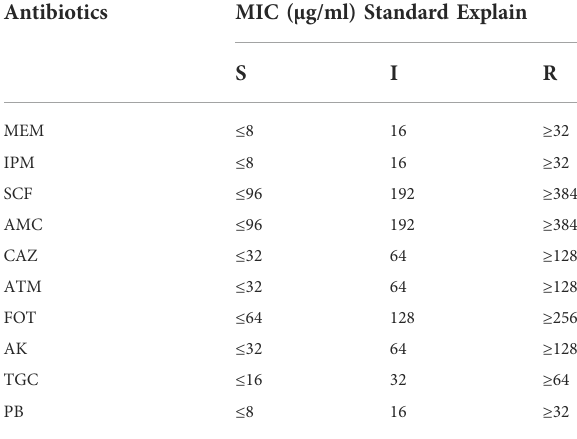
TABLE 2 The scope of drug sensitivity results of nematode model.